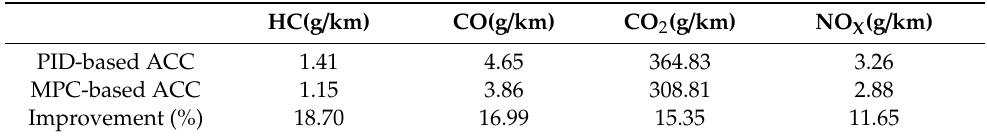
Table 3. Emissions results in Scenario